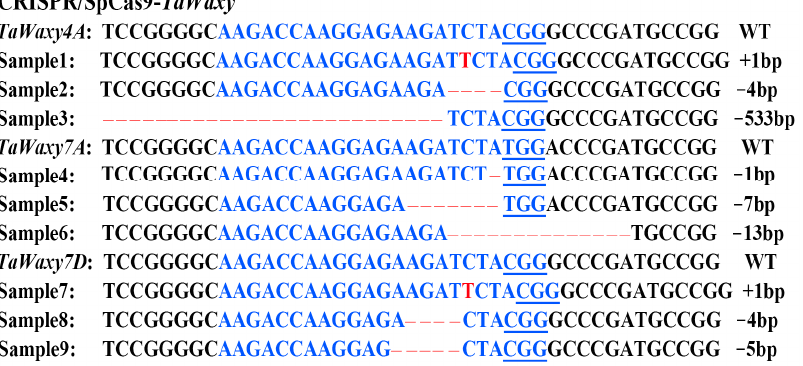
Figure 2. InDel mutations of the TaWaxy gene in the mutants generated from the immature embryos under nicotinamide treatment in vitro. The PAM region is underlined; blue letters indicate sgRNA sequences, red letters indicate insertions, and dashed lines represent nucleotide deletions.